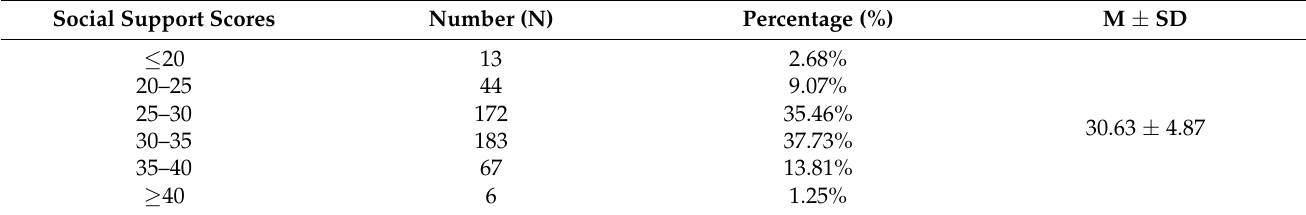
Table 2. Social support scores of older people in